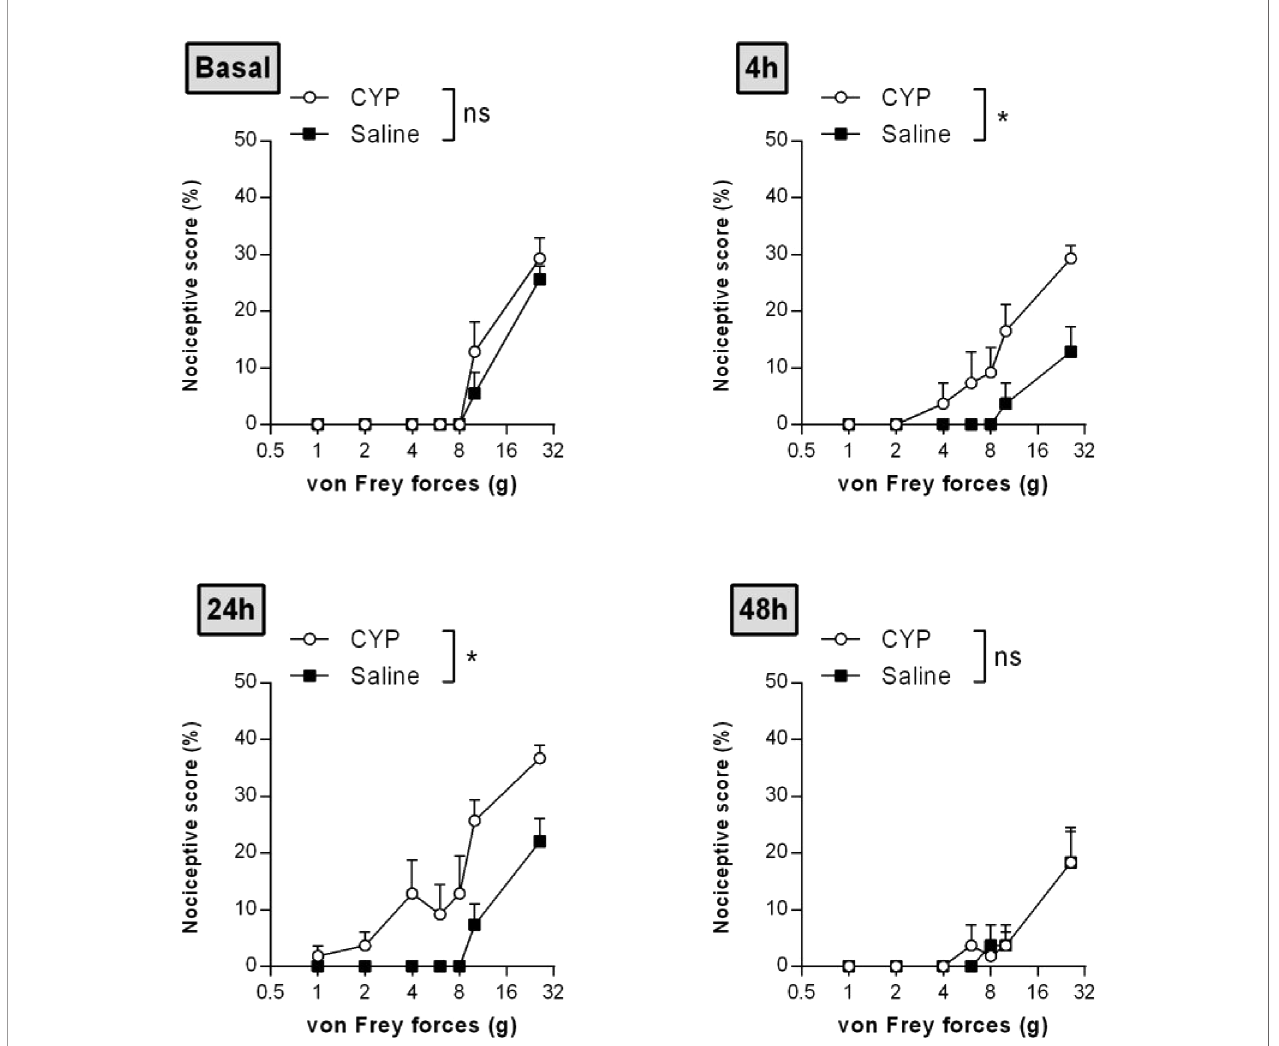
FIGURE 4 | Single injection of CYP-induced short-lasting bladder pain. Rats received single dose of CYP (40 mg/kg, i.p.) or saline (5 ml/kg, i.p.). Nociceptive response was assessed in a time-course study over 48 h by von Frey testing. Nociceptive score was expressed as the percentage of the maximal score for each von Frey force. Data represent mean values ± SEM (n = 6/group). ns p > 0.05, *p < 0.05 (two-way RM